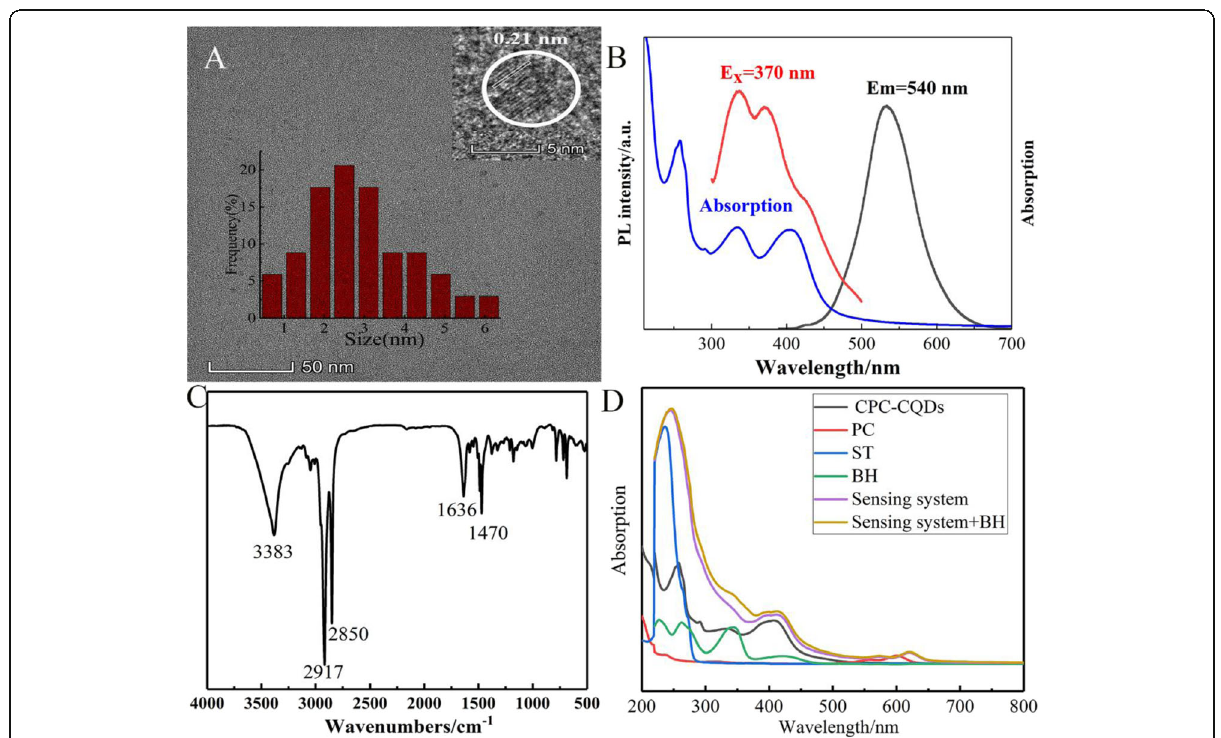
Fig. 1 a TEM images of CPC-CQDs (inset: HRTEM image of CPC-CQDs; background: particle size distribution of CPC-CQDs). b Absorption (blue), excitation spectra (red), and emission spectra (black) of CPC-CQDs. c FTIR spectra of CPC-CQDs. d Absorption of the materials and